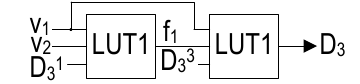
Figure 9. Implementing the function D 3